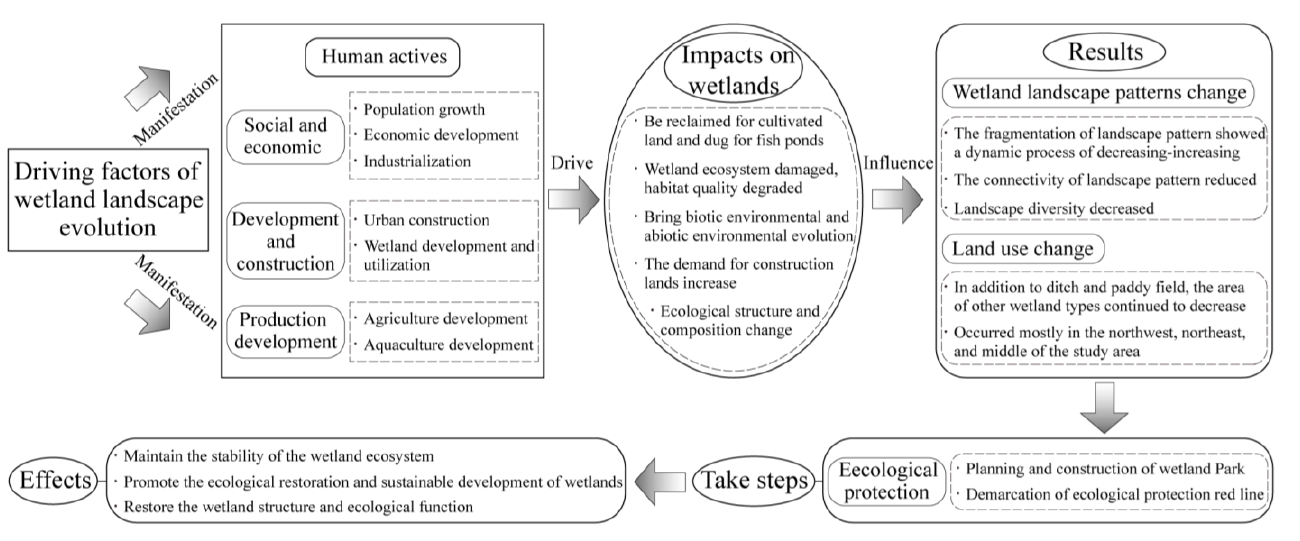
Figure 9. Driving factors and results of the evolution of the wetland landscape.